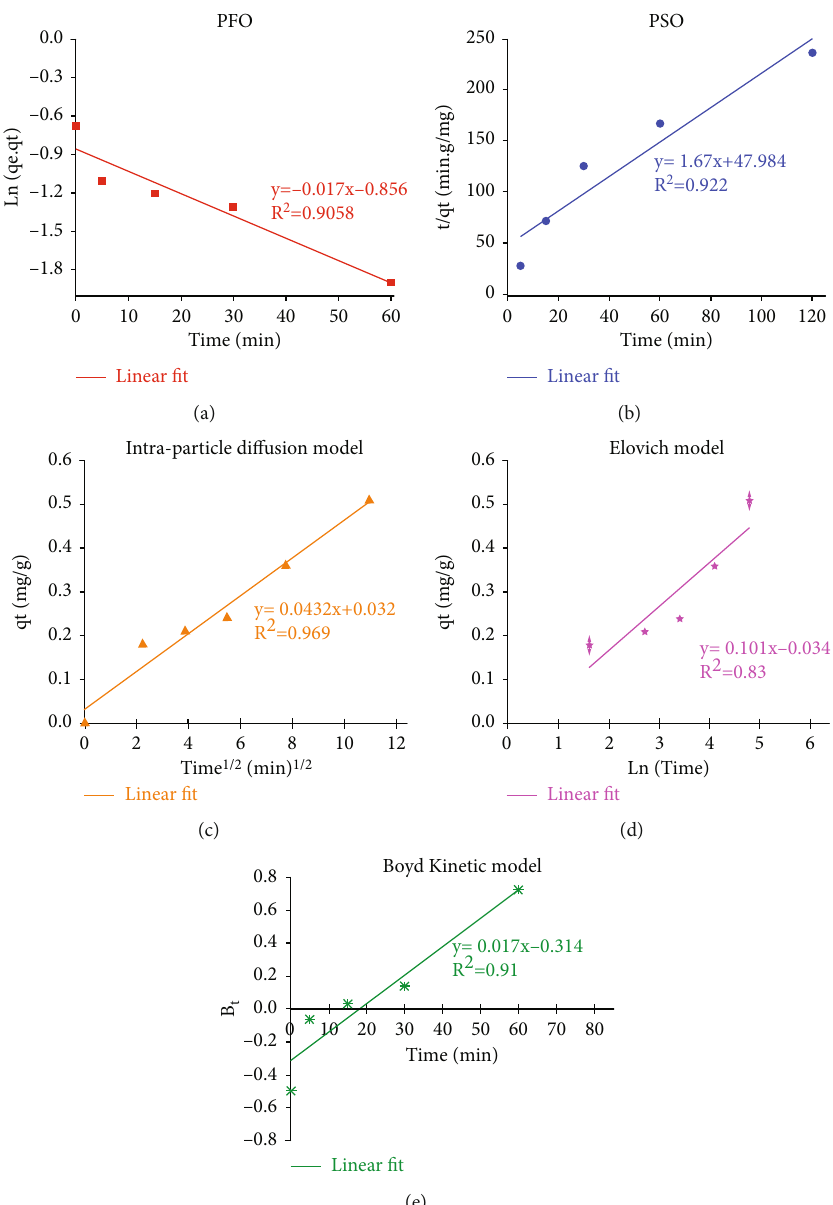
Figure 5: Kinetic studies: (a) pseudo- fi rst-order (PFO), (b) pseudo-second-order (PSO), (c) intraparticle di ff usion, (d) Elovich, and (e) Boyd kinetic